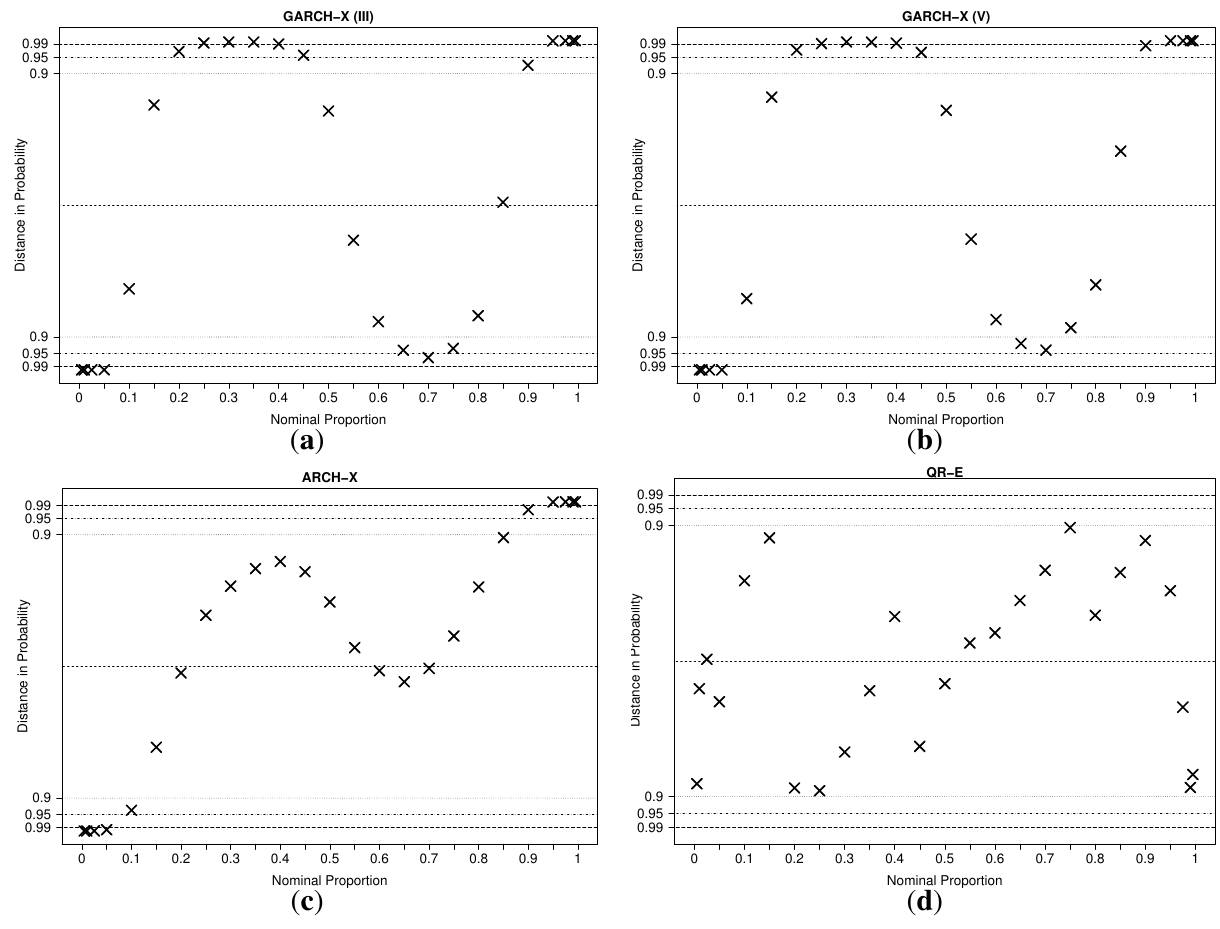
Figure 9. Reliability diagrams on probability paper for the GARCH-X models ( a , b ), the ARCH-X model ( c ) and the QR-E model ( d